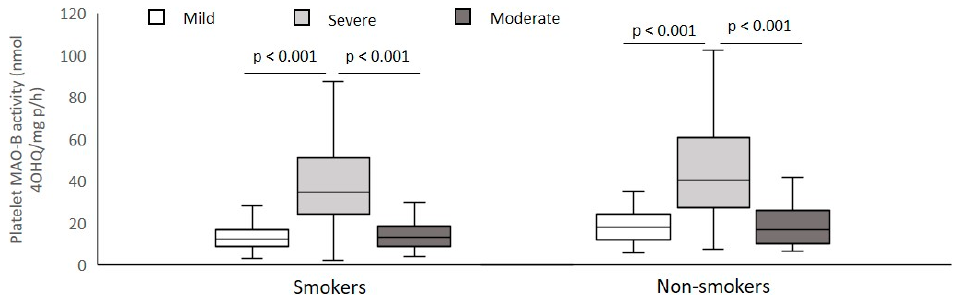
Figure 2. Platelet MAO-B activity in subjects with mild, moderate, and severe PTSD symptoms subdivided according to smoking status.